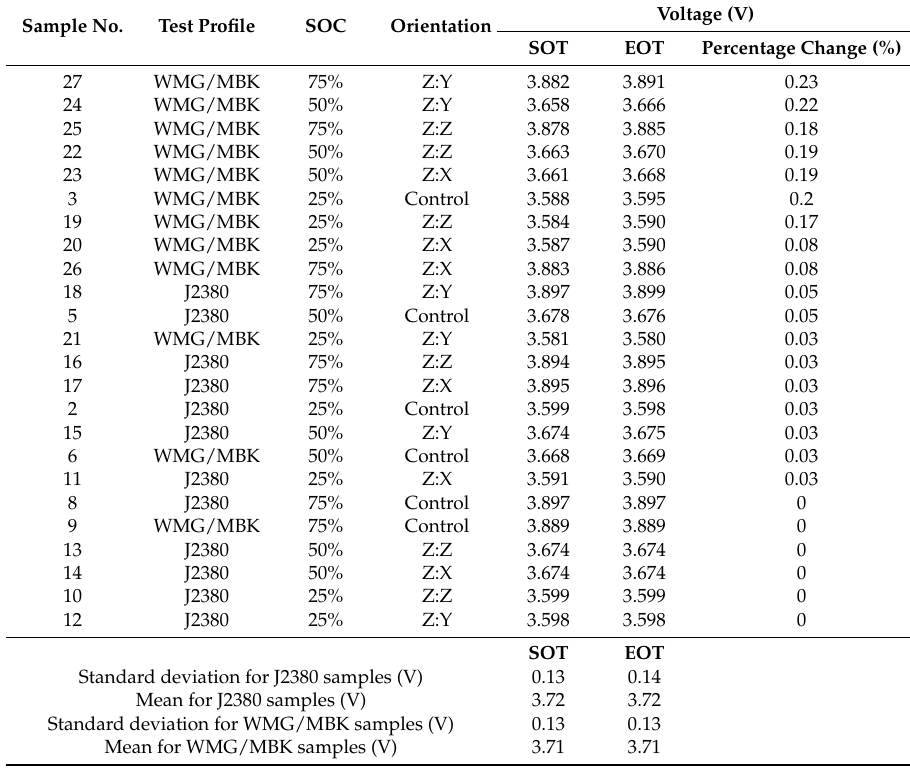
Table 11. Start and end of test open-circuit voltage (OCV) measurements of all cells evaluated. Sample No.